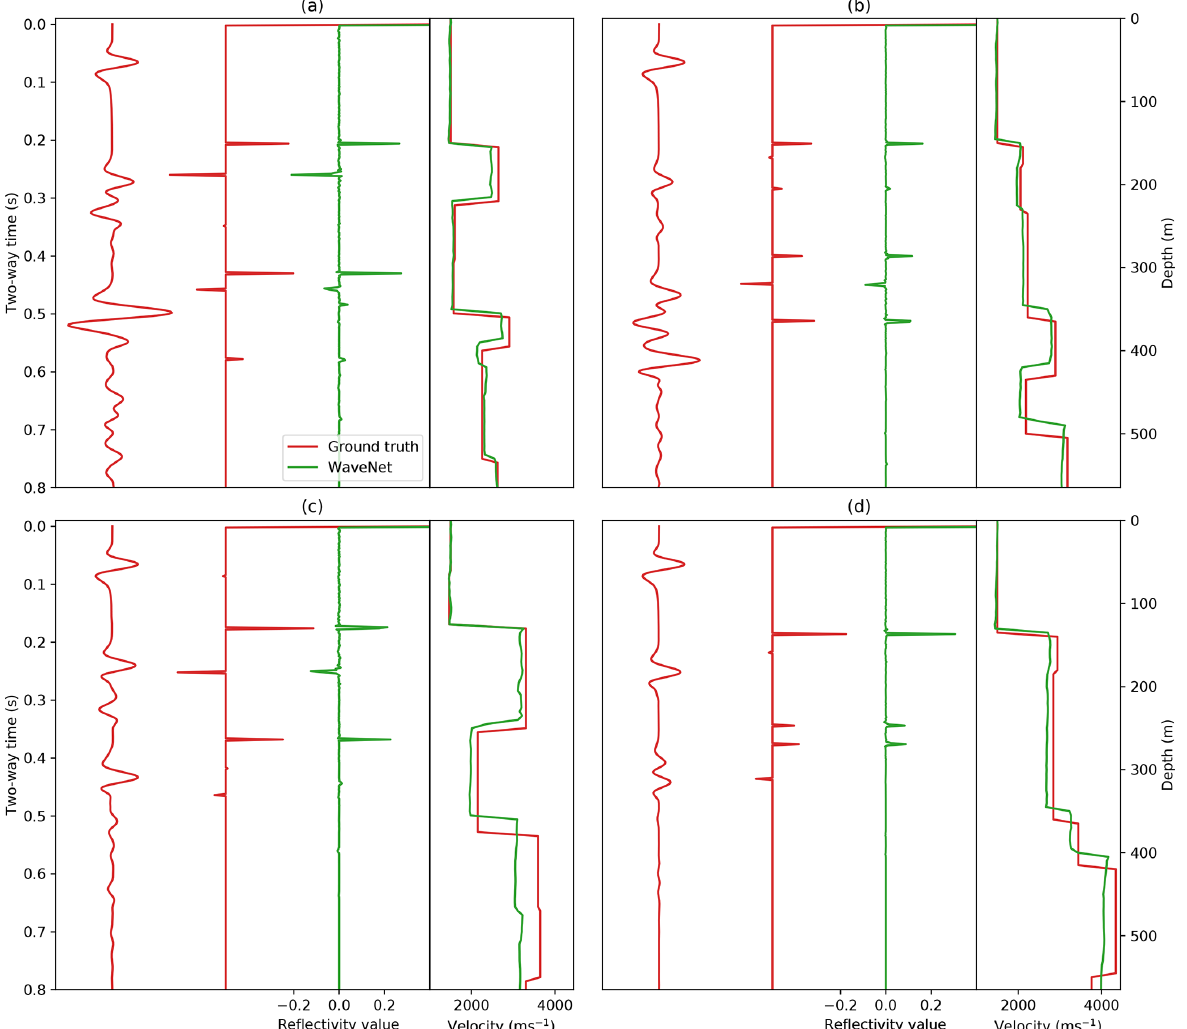
Figure 12. Inverse WaveNet predictions for four examples in the test set. Red shows the input pressure response at the zero-offset receiver location, the ground truth reflectivity series and its corresponding velocity model. Green shows the inverse WaveNet reflectivity series prediction and the resulting velocity